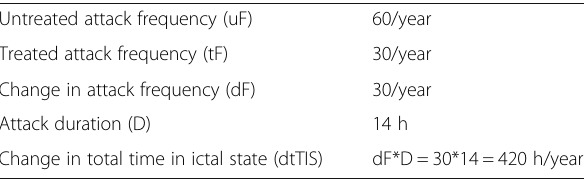
Table 2 Imaginary numerical example of preventative treatment effect in an individual Untreated attack frequency (uF) Treated attack frequency